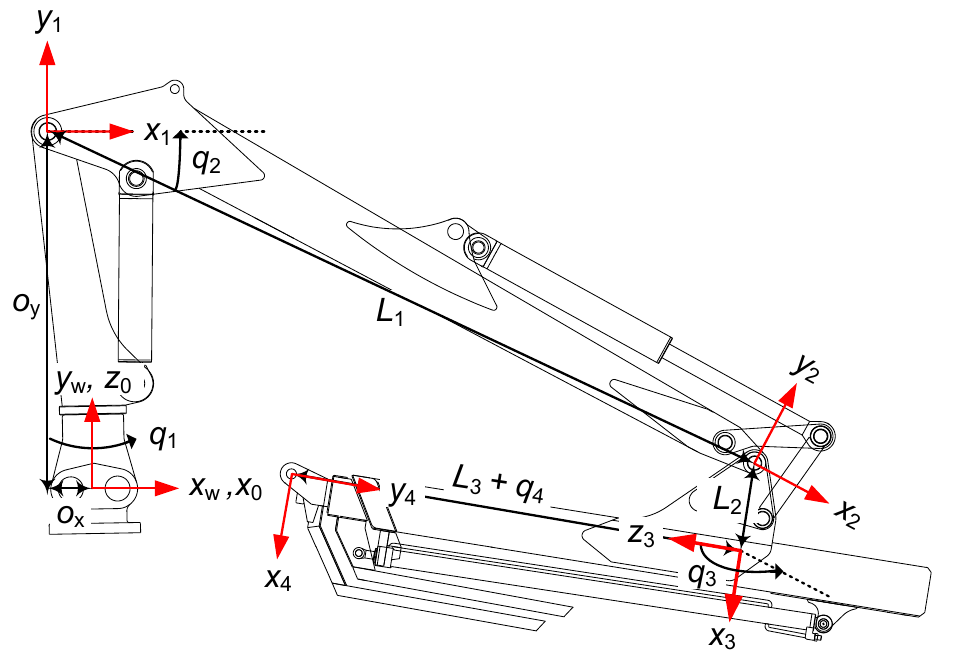
Figure 5. 4-DOF kinematically redundant hydraulic manipulator, with coordinate frames attached to the links based on the classical Denavit-Hartenberg